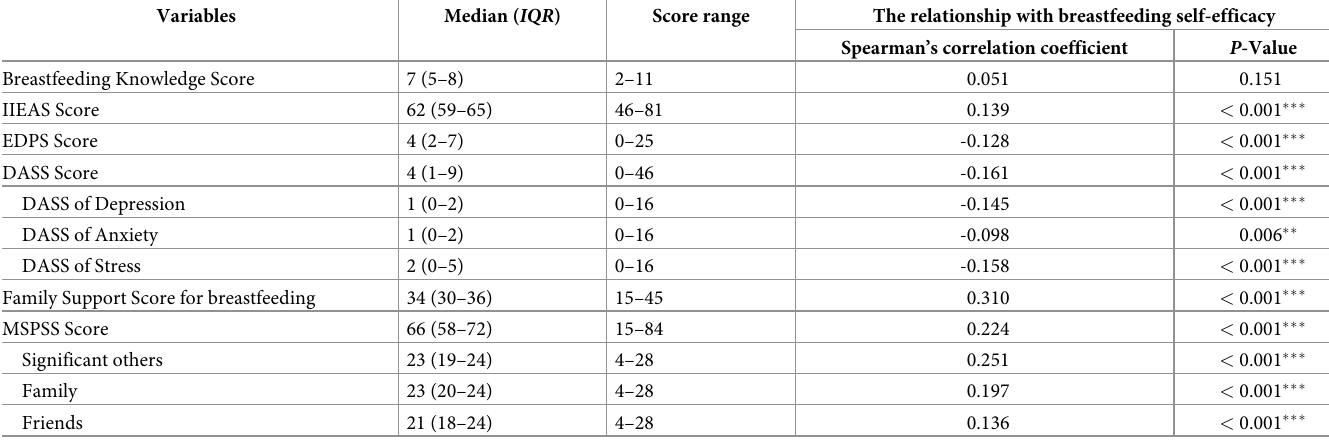
Table 5. Descriptive statistics of the Dennis breastfeeding self-efficacy framework variables excluding breastfeeding problems and univariate correlations with breastfeeding self-efficacy (N =